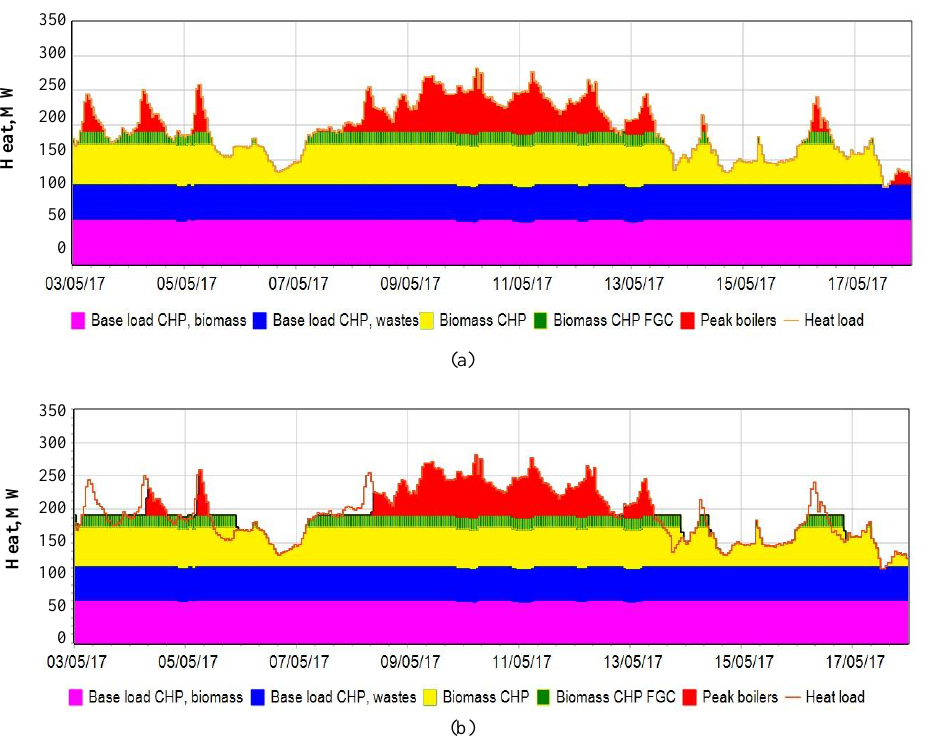
Fig. 5. Scenario B: Example of CHP operation (a) without and (b) with an accumulator tank (7000 m 3